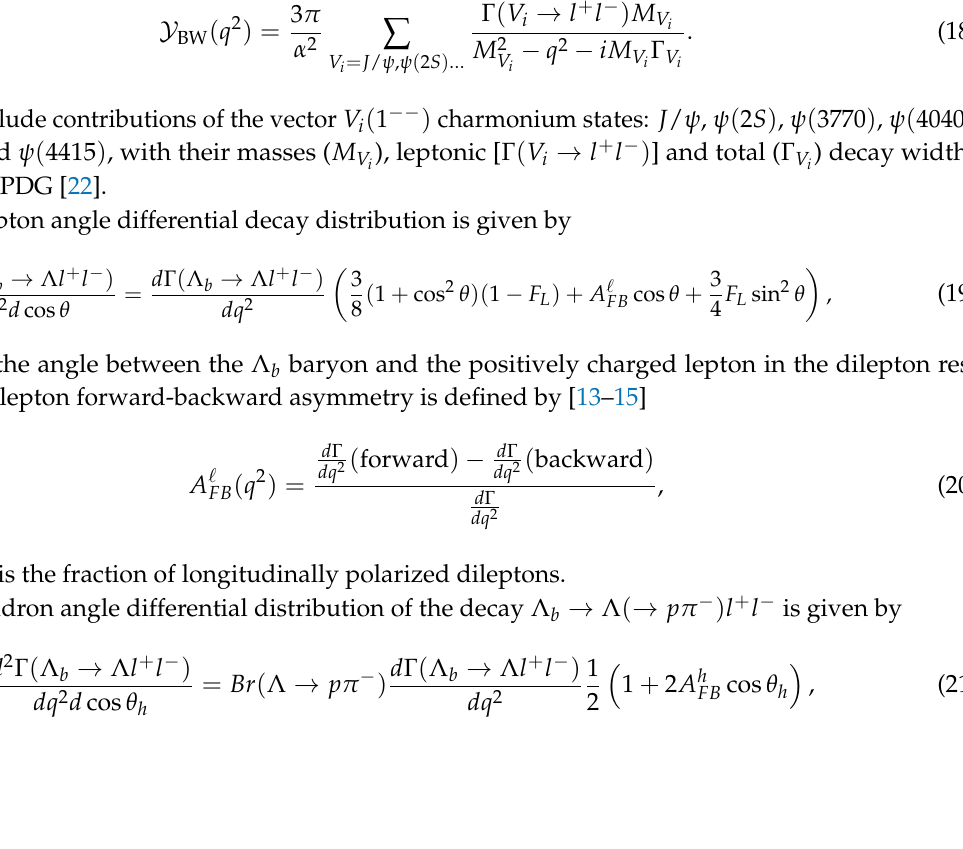
Figure 5. Form factors of the rare weak Λ b tensor ( c ) and axial tensor ( d ) weak